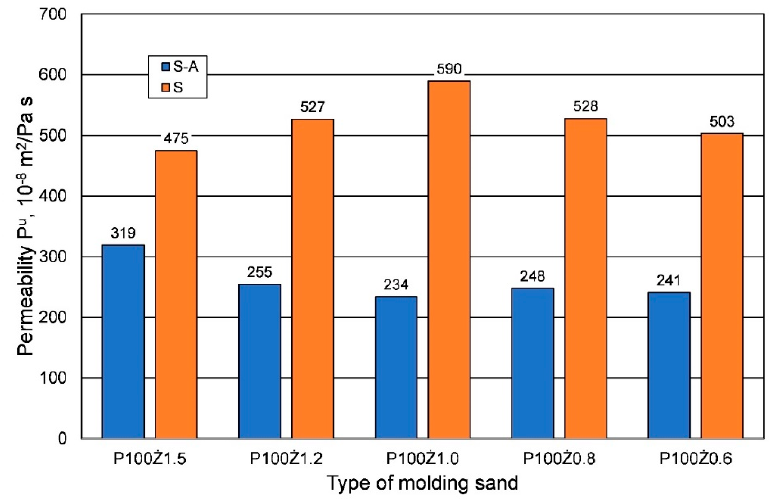
Figure 5. Permeability P u of hardened molding sand (24 h) prepared on the basis of fresh chromite sand, depending on weather conditions, for different amounts of added binder.